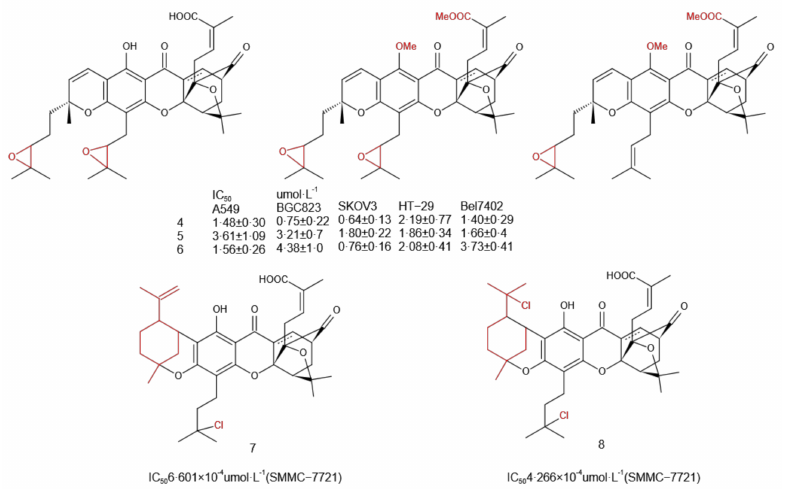
Figure 4. Structural modifications of the carbon–carbon double bonds at C-32/33 and